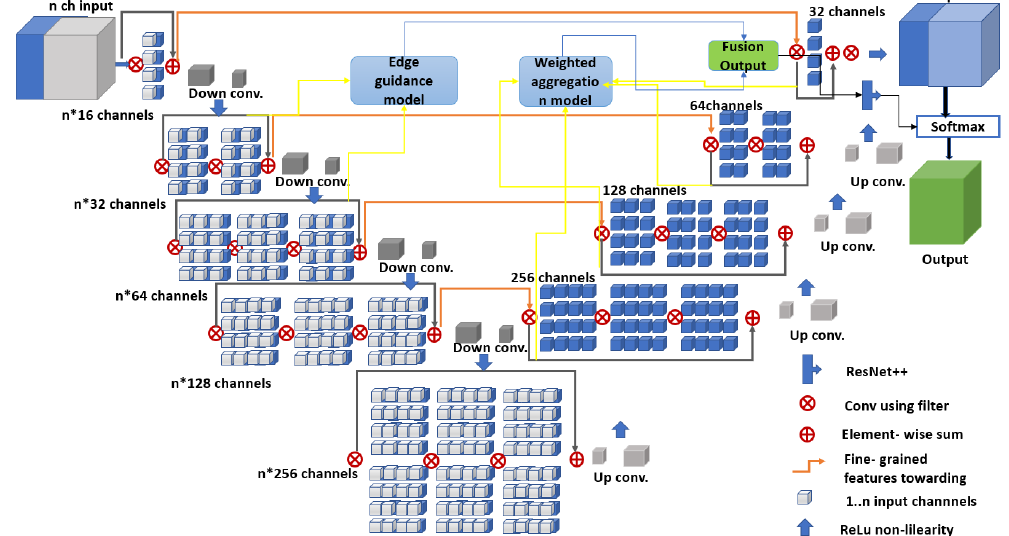
Figure 7. Schematic representation of the hybrid V-Net architecture. The encoder phase consists of two fusion blocks while the decoder phase consists of the ET-Net architecture and the output layer ResNet ++